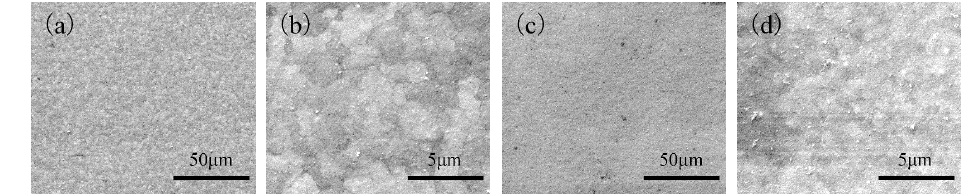
Figure 5. SEM images of bright tin plating treated with ( a , b ) chemical passivation and ( c , d ) electrolytic